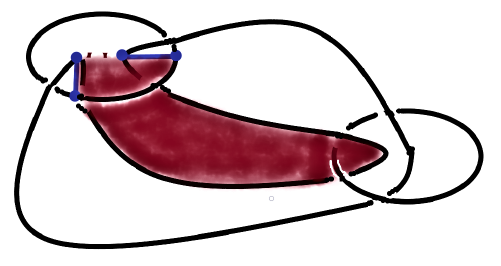
Figure 8. The shaded portion represents the area bounded by the ER bridge instantiated through the Borromean